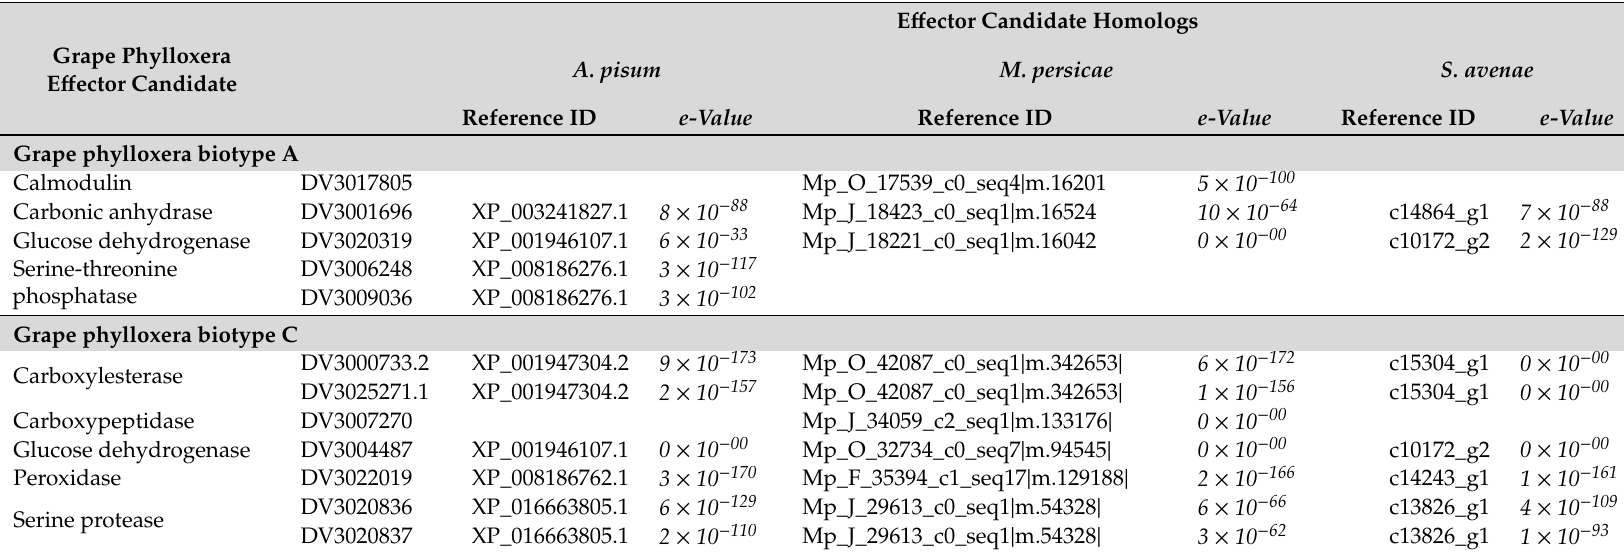
Table 2. BlastP results showing e ff ectors homologs conserved between two grape phylloxera biotypes (A, C) and predicted e ff ector candidates of A. pisum [61,62], M. persicae [63], and S. avenae [64]. The functional annotations were retrieved from the grape phylloxera genome [44]. The match quality was characterized by the e-value. The table represented a selection of the e ff ector homologues listed in File S4 a /